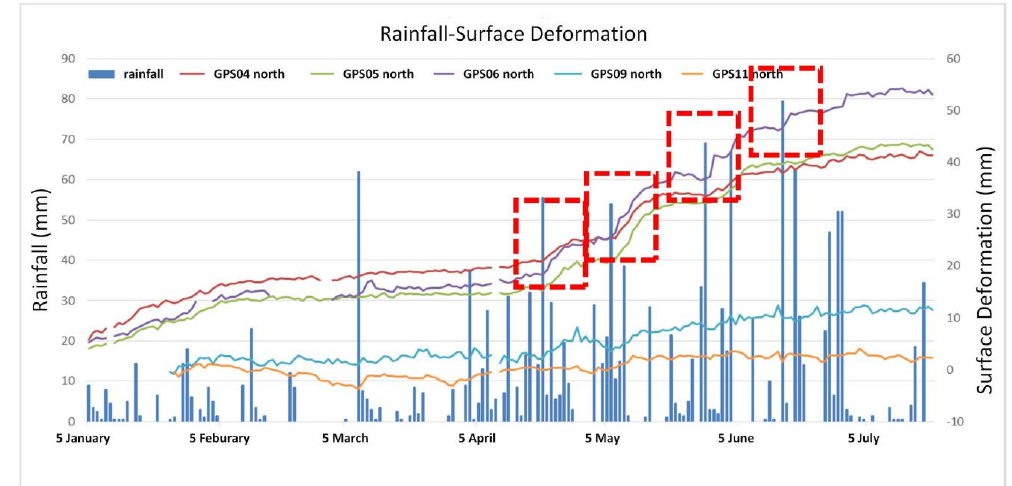
Figure 11. Record of rainfall and surface deformation in the #10 slope.